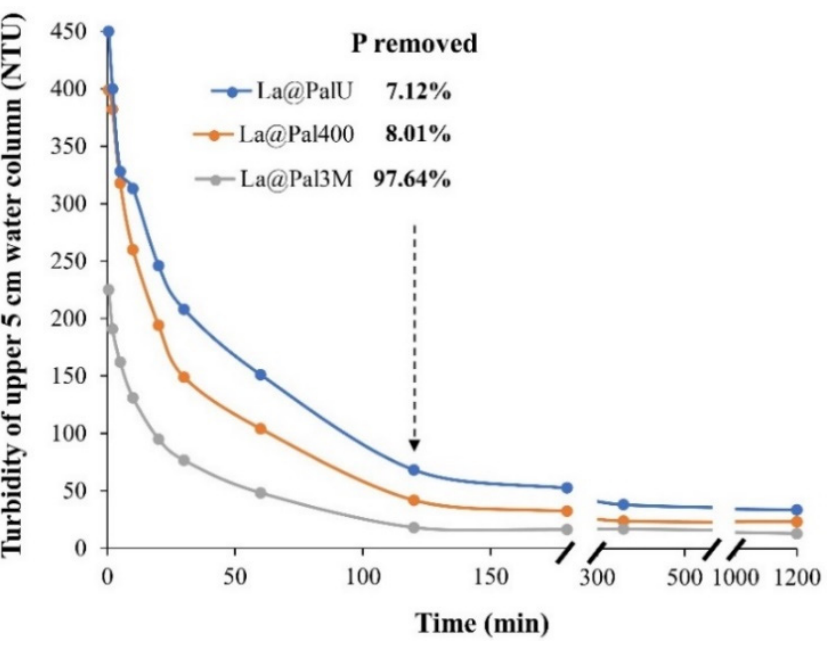
Figure 7. Turbidity measurement of selective materials over a series of times in the water column.